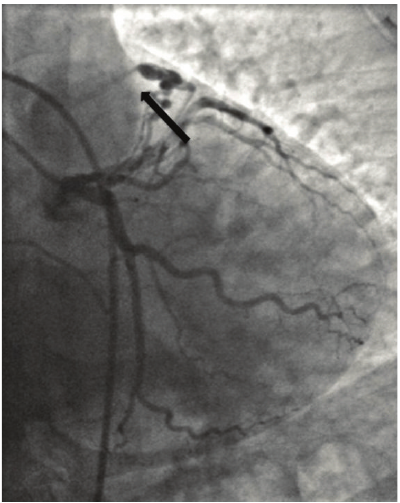
Figure 3: Coronary angiography demonstrating fistula between the proximal circumflex artery and pulmonary artery.